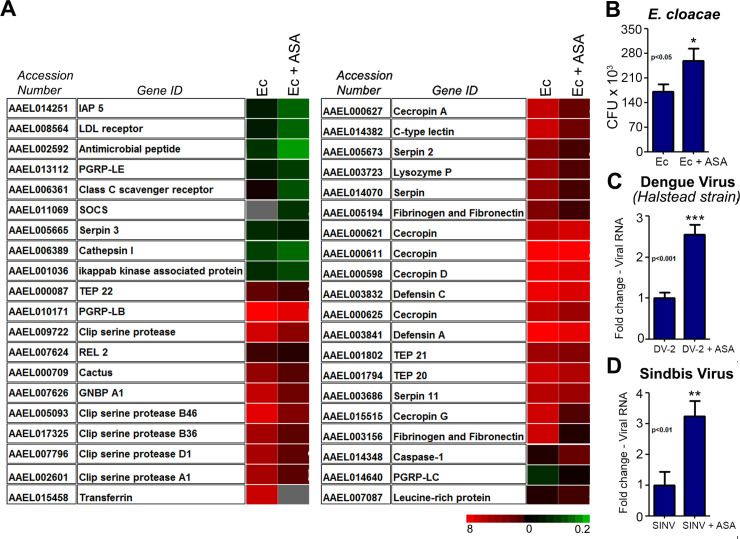
ASA treatment compromises the proper expression of immune genes and the ability to control bacterial and viral infections.(A) Immune related genes modulated by ASA treatment in the microarray analysis. Green color indicates down-regulated genes and red color is referred to up-regulated ones. Complete detailed expression data can be seen in S1 Dataset. A complete list of the immune genes regulated by ASA treatment can be seen in S2 Dataset. (B) Number of CFU recovered from the supernatant of Aag2 cells that were pre-treated or not with ASA before Ec exposure. (C-D) Viral RNA recovered from the supernatant of Aag2 cells infected with Dengue and Sindbis virus after pretreatment with Aag2 cells (C) Dengue virus RNA recovered after 4 days post infection (D) Sindbis virus RNA recovered 2 days post infection. Error bars represent mean ± SEM. Unpaired t-test, *P≤0.05, **P≤0.01, ***P≤0.001. Each biological replicate corresponds to a well on a plate and at least three independent experiments were performed per assay. Viral RNA amounts were normalized by the number of cells present in the well, which were determined using trypan blue stain.